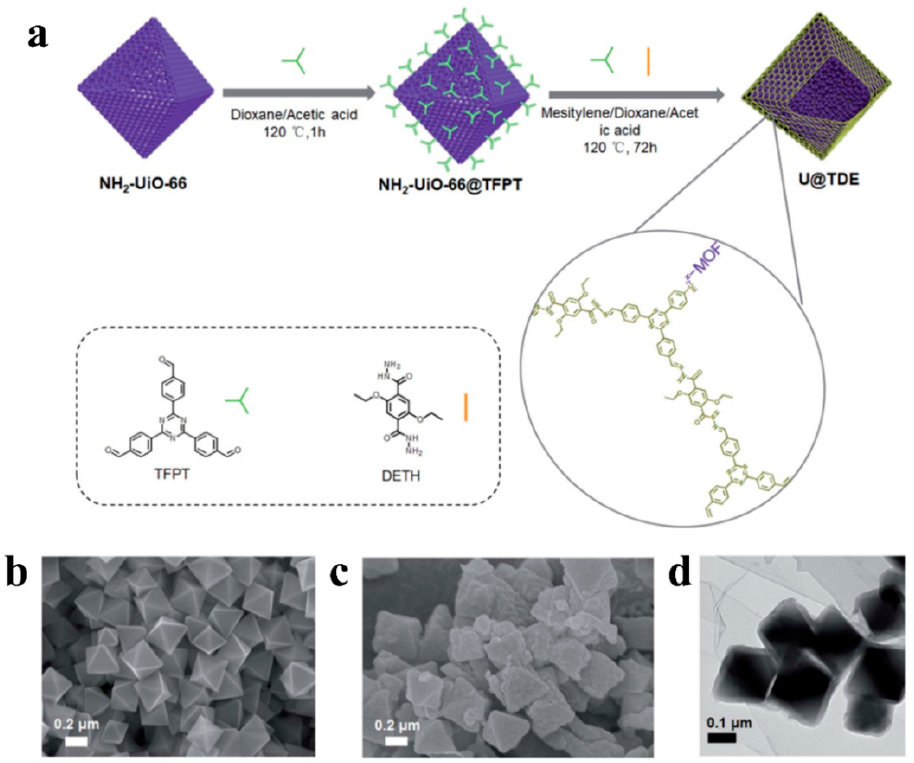
Figure 15. ( a ) The schematic illustration of the synthesis steps of U@TDEn (NH 2 -UiO-66@TFPT- DETH) core-shell hetero-frameworks. ( b ) The SEM image of NH 2 -UiO-66. ( c , d ) The SEM and TEM images of U@TDE4. Reproduced with permission from Ref. [82].